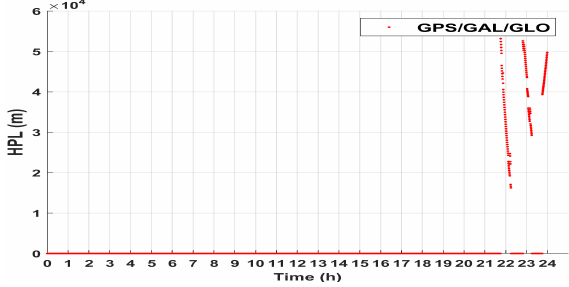
Figure 4. HPLs of combined GPS, Galileo and GLONASS data at station ABMF.